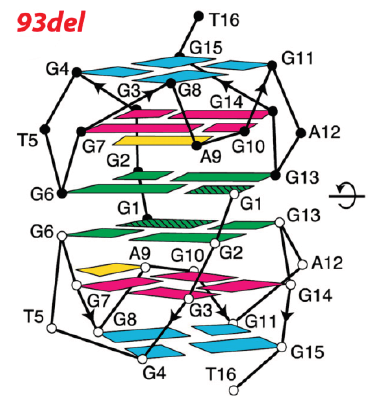
Figure 6. The dimeric G-quadruplex structure of 93del (reproduced from ref. [56] with permission of The National Academy of Sciences, USA—2005).